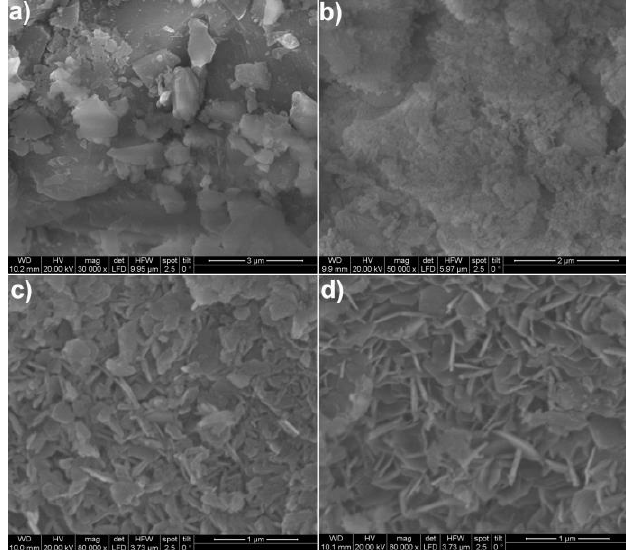
Figure 4. SEM images of ( a ) MgCO 3 , ( b ) calcined MgCO 3 ( CO 3 -1 ), ( c ) calcined MgCO 3 , rehydrated for 24 h in liquid water ( CO 3 -3 ), ( d ) material from image c after calcination ( CO 3 -4